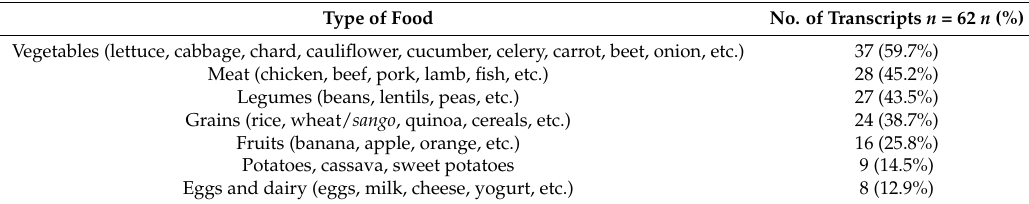
Table 1. “Buena alimentaci ó